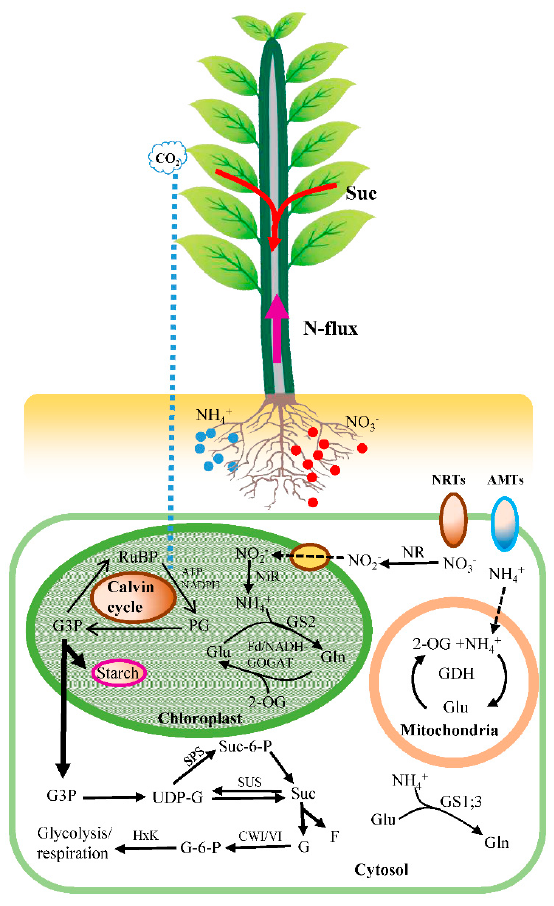
Figure 1. A schematic model of C/N metabolism in plants. Glyceraldehyde 3-phosphate (G3P) produced by CO 2 fixation in Calvin cycle can be exported to the cytosol or used to synthesize starch in chloroplast. Sucrose is synthesized by the enzyme sucrose phosphate synthase (SPS) via the consumption of uridine diphosphate glucose (UDP-G) from the Calvin cycle and fructose-6-phosphate. Sucrose can be transported to the sink tissues and hydrolyzed to glucose and fructose by cell wall invertase (CWI) and vacuolar invertase (VI). The glucose is phosphorylated by hexokinases (HxKs) and further utilized for glycolysis and respiration. NH 4+ and NO 3 − are absorbed in the roots by various transporters for ammonium ( AMTs ) and nitrate ( NRTs ). After uptake, NO 3 − is reduced to NH 4+ via nitrate reductase (NR) and nitrite reductase (NiR). Then, NH 4+ is assimilated to glutamine (Gln) and glutamate (Glu) by glutamine synthetase and glutamate synthase (GS/GOGAT) or the glutamate dehydrogenase (GDH) pathways.